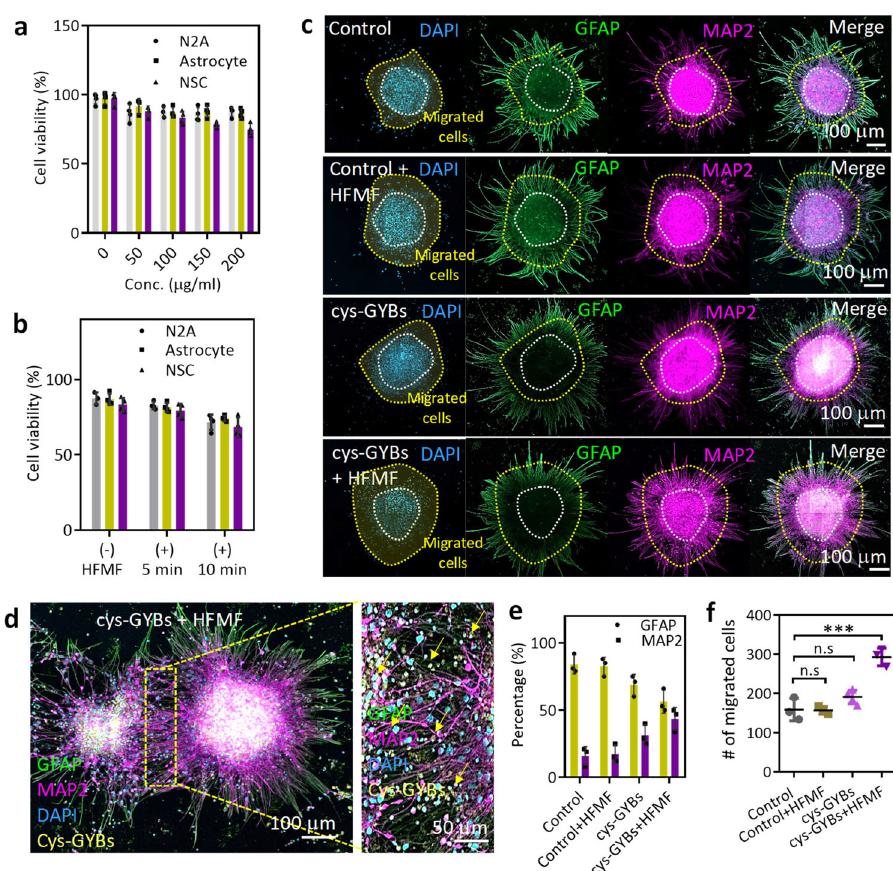
Fig. 4 | Electromagnetized cys-GYBs stimulate neuron differentiation. a Cell viability of NSCs, N2A cells and astrocytes treated with different concentrations of cys-GYBs.Errorbarsrepresentmean±s.d., n = 5. b CellviabilityofNSCs,N2Acells and astrocytes treated with 100 μ g/ml cys-GYBs with or without HFMF exposure. Errorbarsrepresentmean±s.d., n = 5. c Fluorescencephotomicrographsshowing the phenotypes of the cells that differentiated from embryonic cerebral cortical neurospheres after 7 days in culture. Anti-MAP-2 (purple) and anti-GFAP (green) antibodies show the immunoreaction of differentiated neurons and astrocytes,